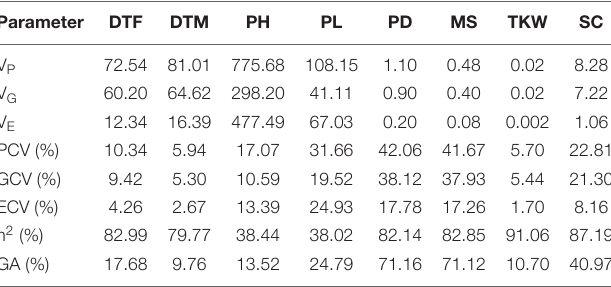
TABLE 2 | Statistical parameters calculated for eight phenotypic characters measured in the F 3